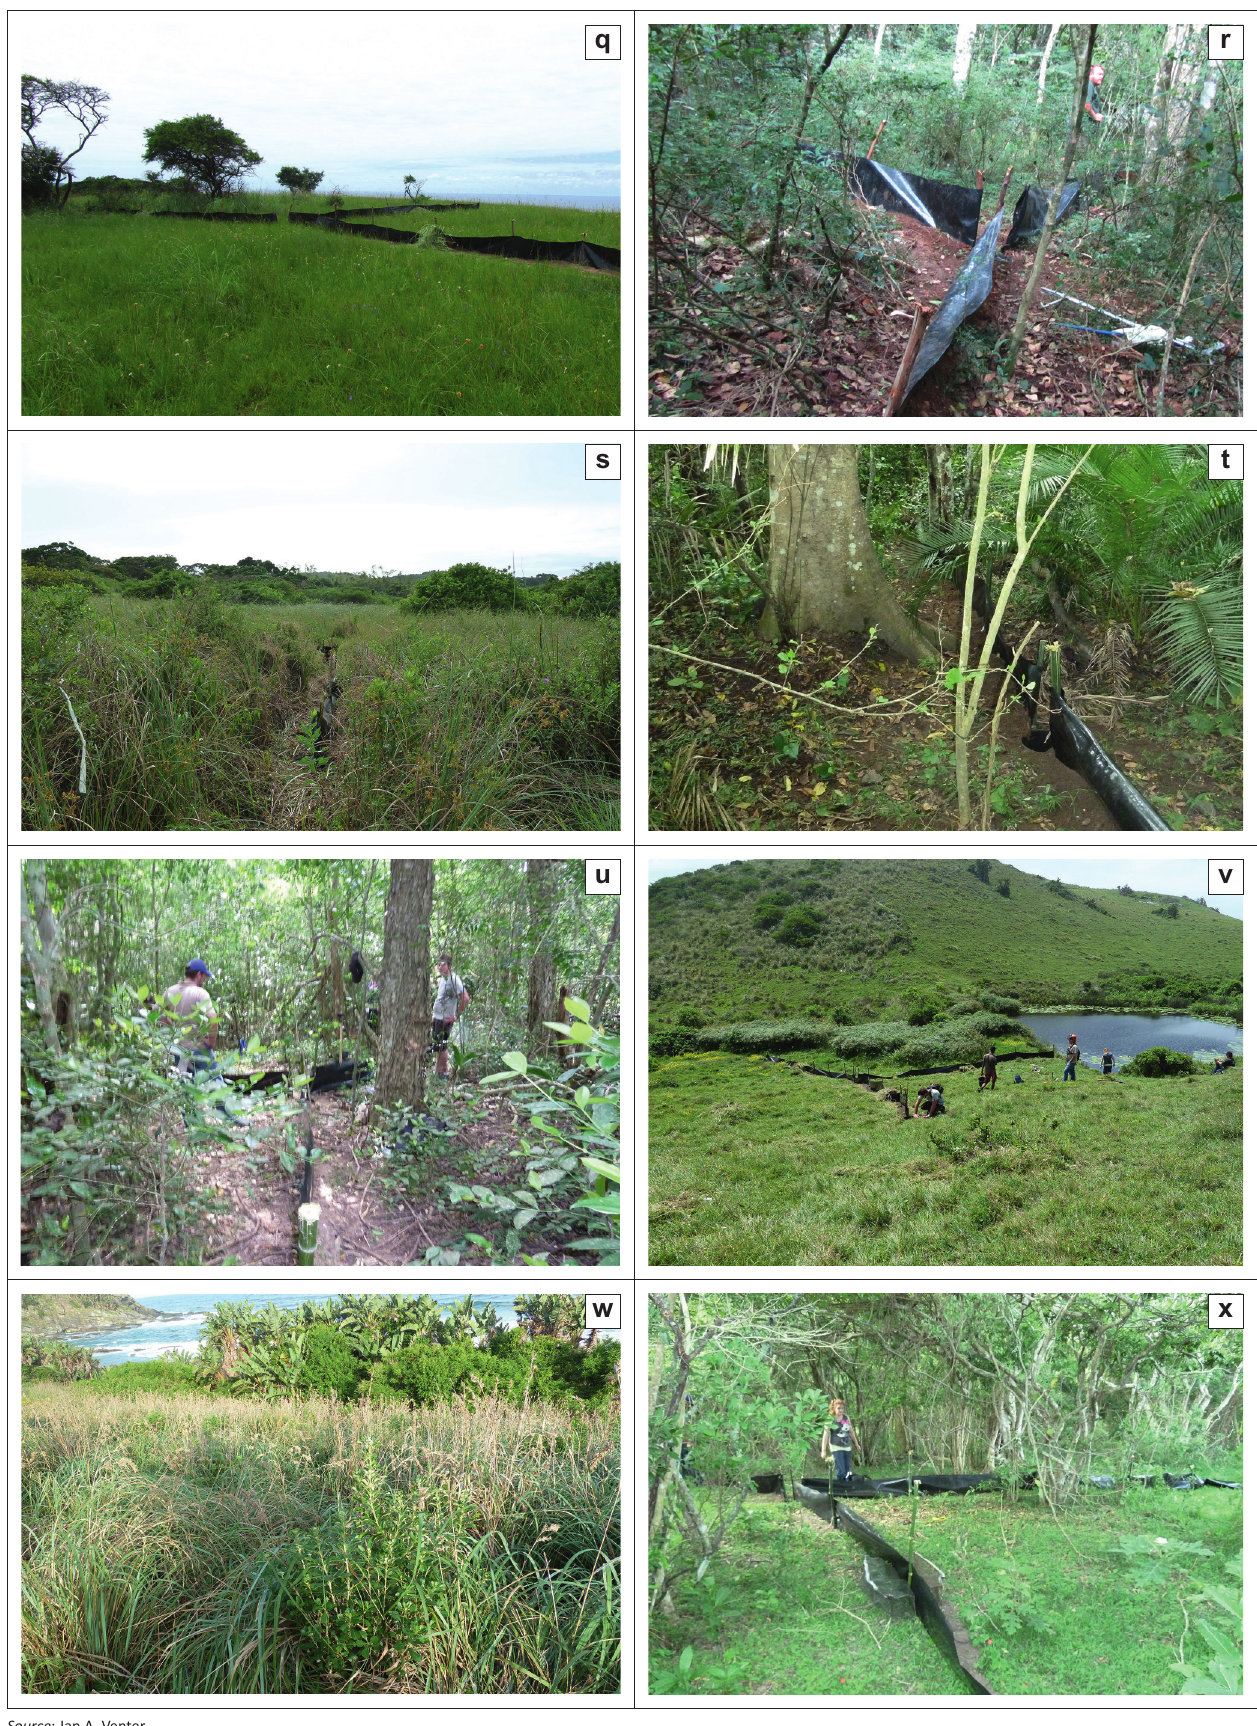
FIGURE 1-A4 (Continues...): (a–ai) Habitat type and trap layout of the respective trap sites surveyed during this study.